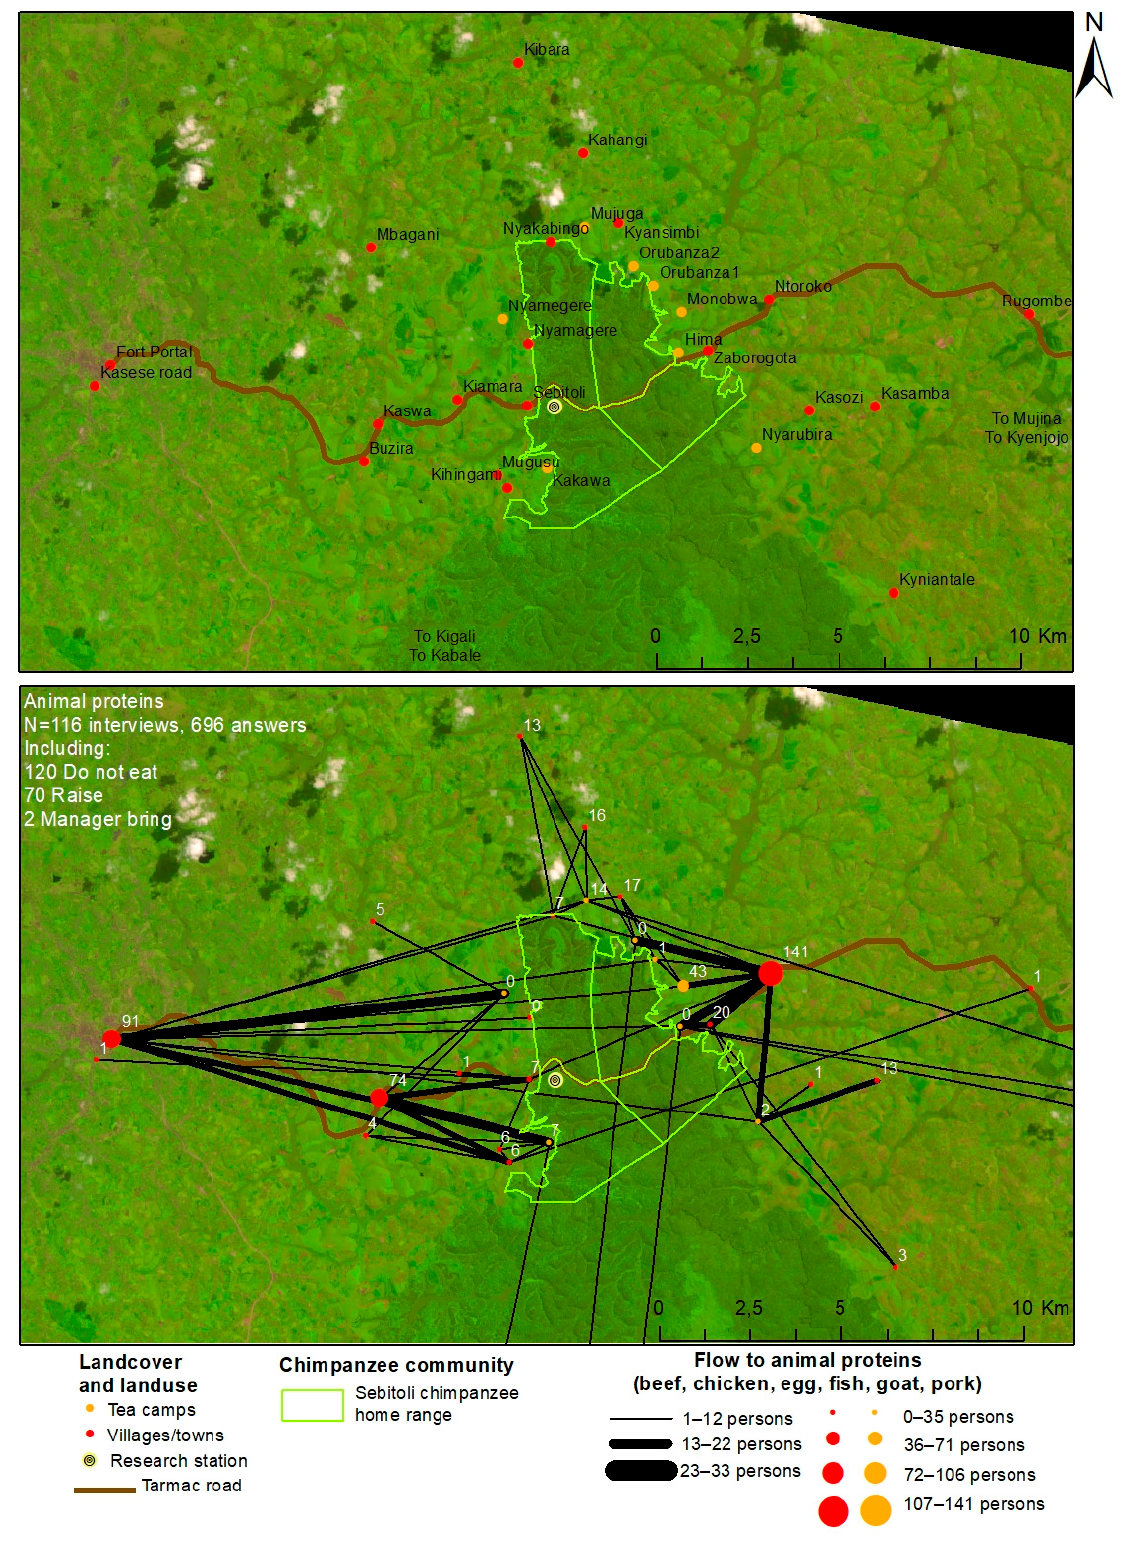
Figure A8. Residency locations of domestic animal meat buyers and locations where they acquire all types of meat combined in Sebitoli area, Kibale National Park, Uganda (May–December 2016).